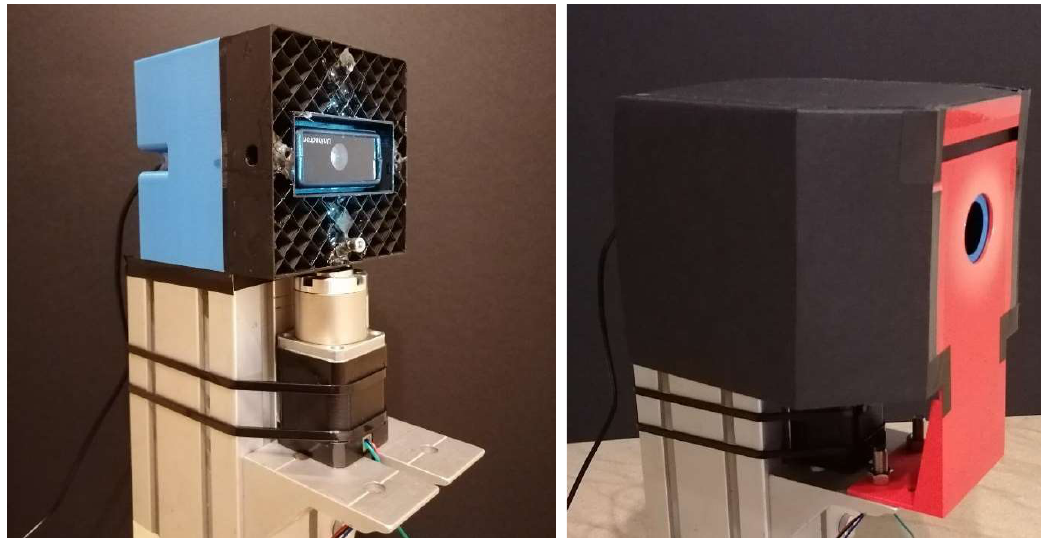
Figure 3. Test setup with the SQM mounted on a rotatory stage ( left ) and with the fixed mask shielding stray lights and diffusion sources ( right ).